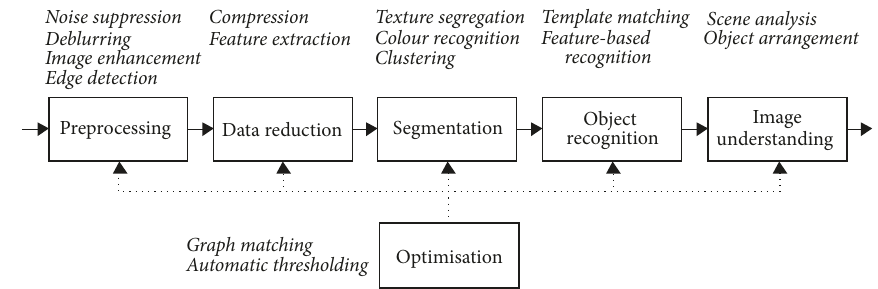
Figure 1: Image processing workflow (figure taken from